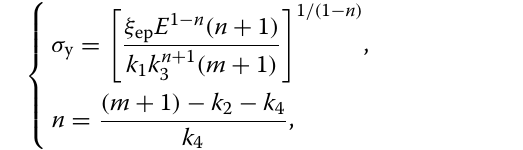
Table 3 FEA conditions for determining k Elastic modulus of the